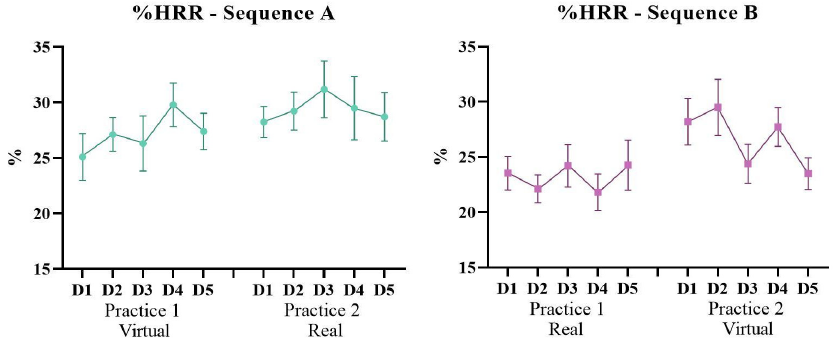
Figure 6. Graphic representation of the %Heart Rate Reserve (%HRR) achieved during the VR activity of Sequences A (virtual–real) and B (real–virtual) during the 10 days of intervention (D1–D5: Days of intervention).